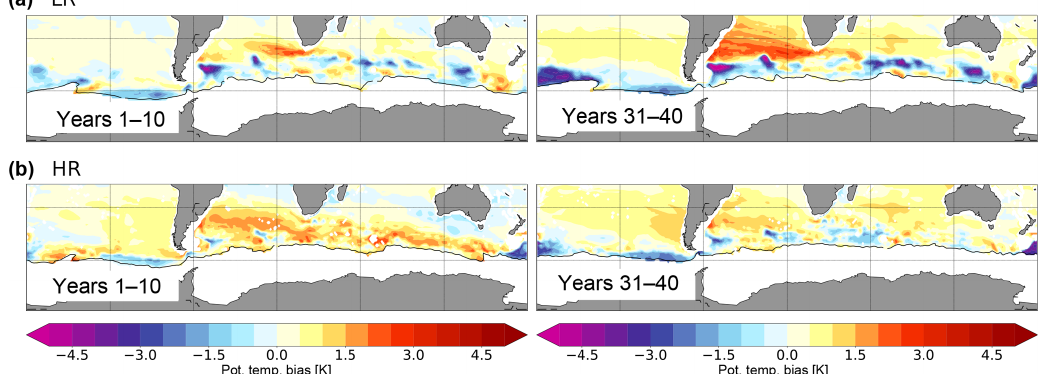
Figure 12. Southern Ocean potential temperature biases [K] with respect to PHC, on the constant isopycnal σ 1 = 31 . 8, in (a) LR and (b) HR for years 1–10 and 31–40. Black contours show the outcropping location of the σ 1 = 31 . 8 isopycnal. Areas to the south of the outcropping location are white (indicating no data). For animations of the bias development with a 10-year running window, see Supplement videos S1 and S2 (Rackow et al.,